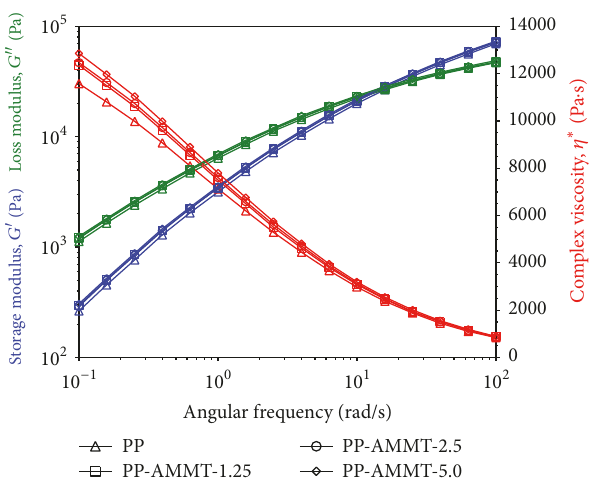
Figure 7: Rheological analysis of PP-AMMT composites.